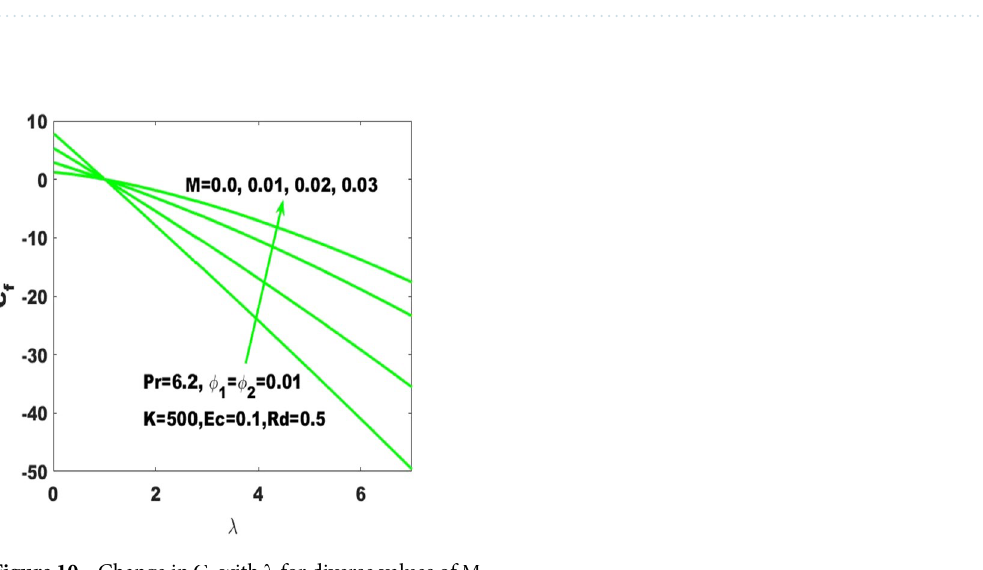
Figure 10. Change in C f with (cid:31) for diverse values of